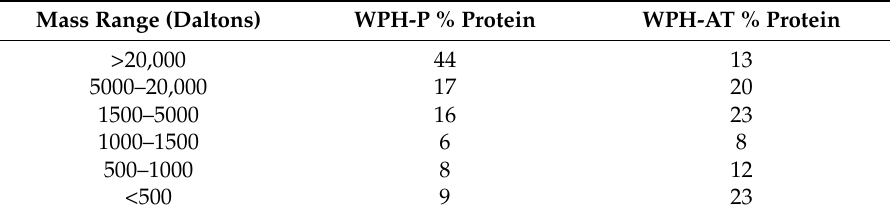
Table 2. Hydrolysate molecular weight profile